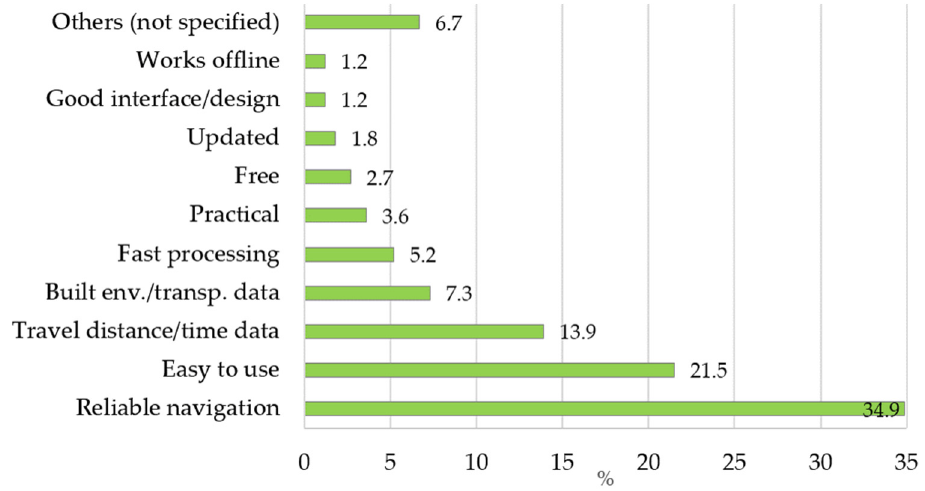
Figure 4. What people like the most in their pedestrian navigation apps.